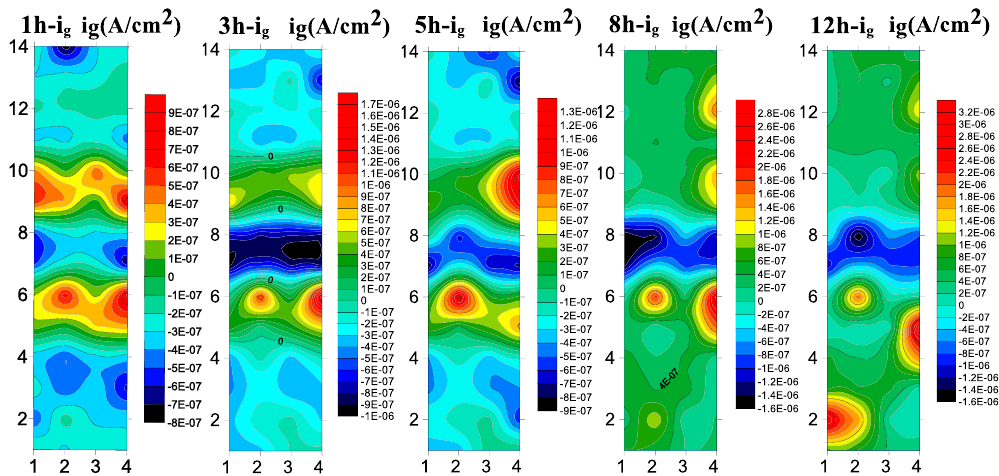
Figure 15. The array electrode results of B10 alloy welded joint area at 1.85 m/s.